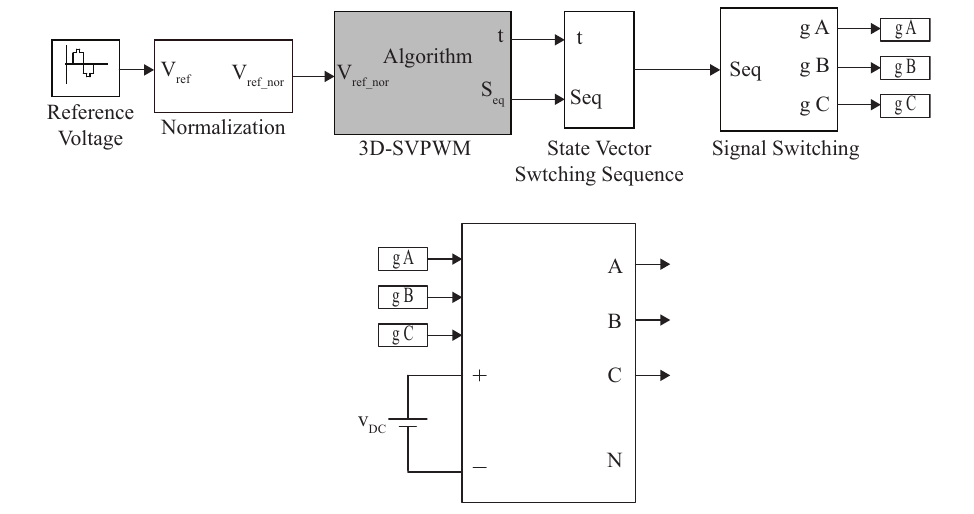
Figure 15. Block diagram for the 3D-SVPWM